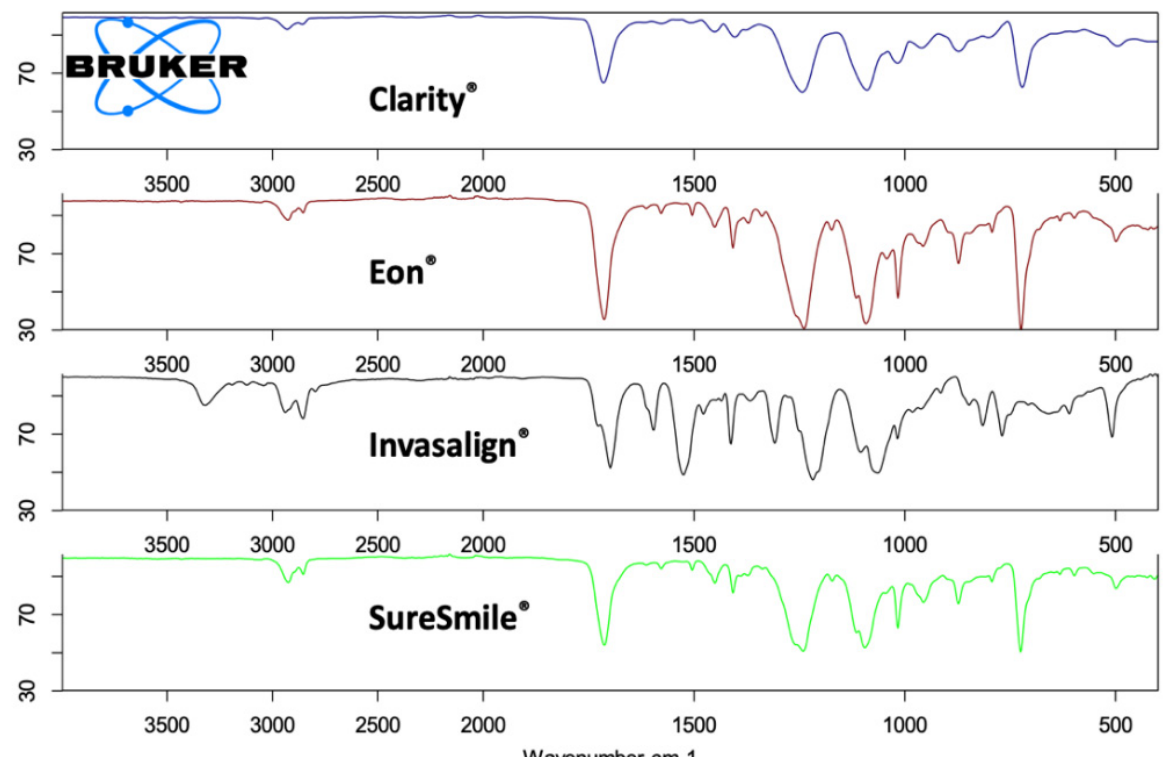
Figure 1. Fourier transform infrared spectroscopy of each clear aligner system.